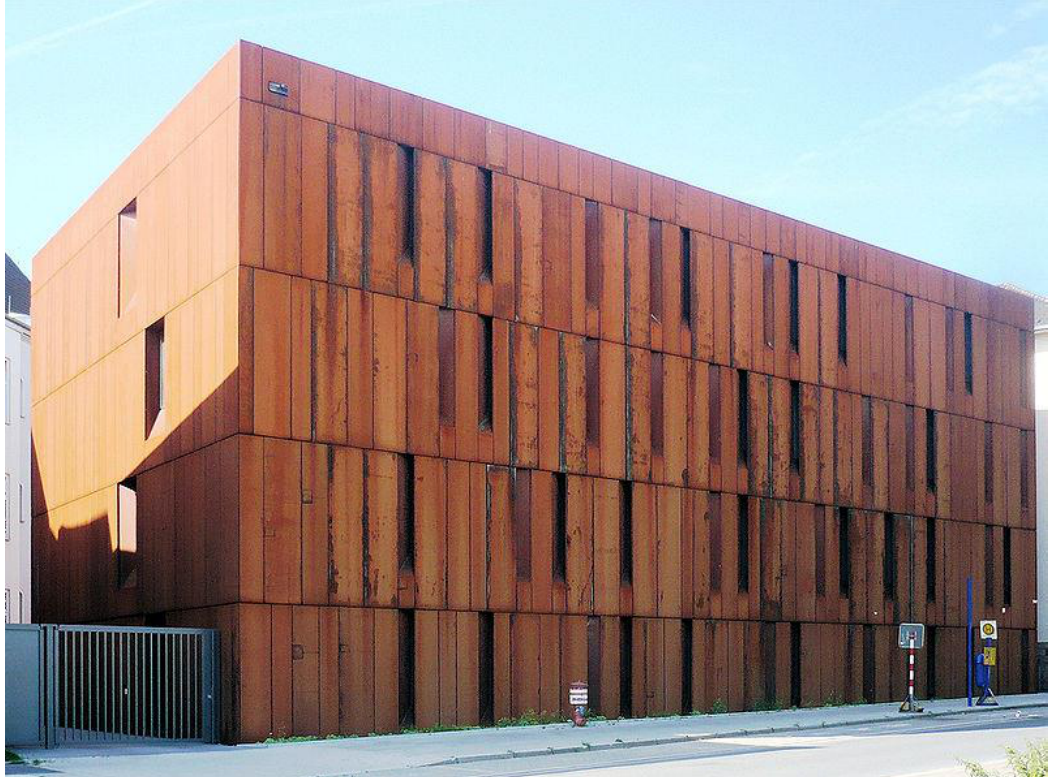
Figure 6. House of Essen History and City Archives, Essen, Germany. Object completed in 2009, architects — Frank Ahlbrecht, Hermann Scheidt [10] Photo — public domain.